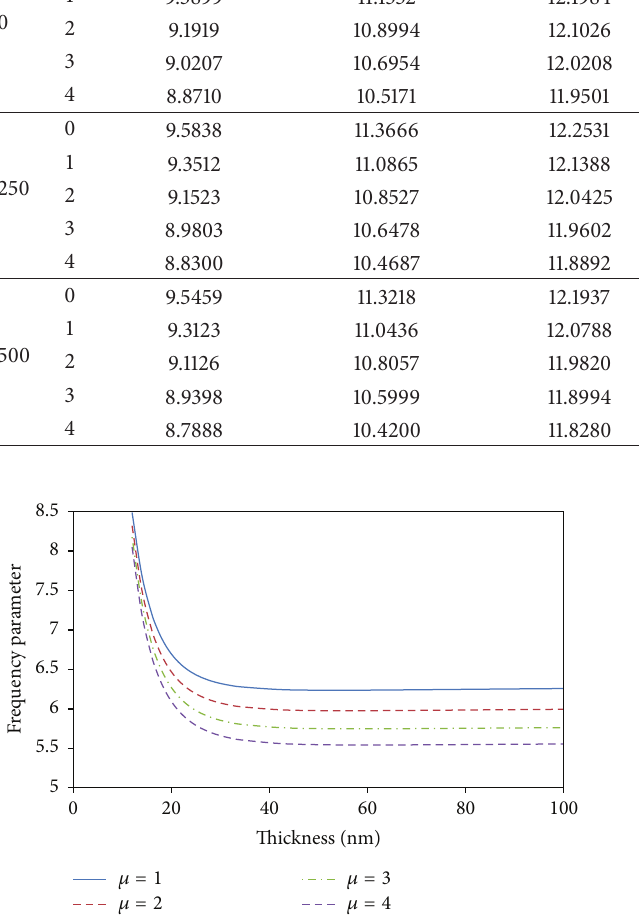
Figure 6: Dimensionless natural frequency with respect to thick- ness ℎ for various nonlocalities (𝐾 𝑤 = 10 10 , 𝐾 𝑝 = 10 −6 , 𝑅 = 30 nm , Δ𝑇 = 100).